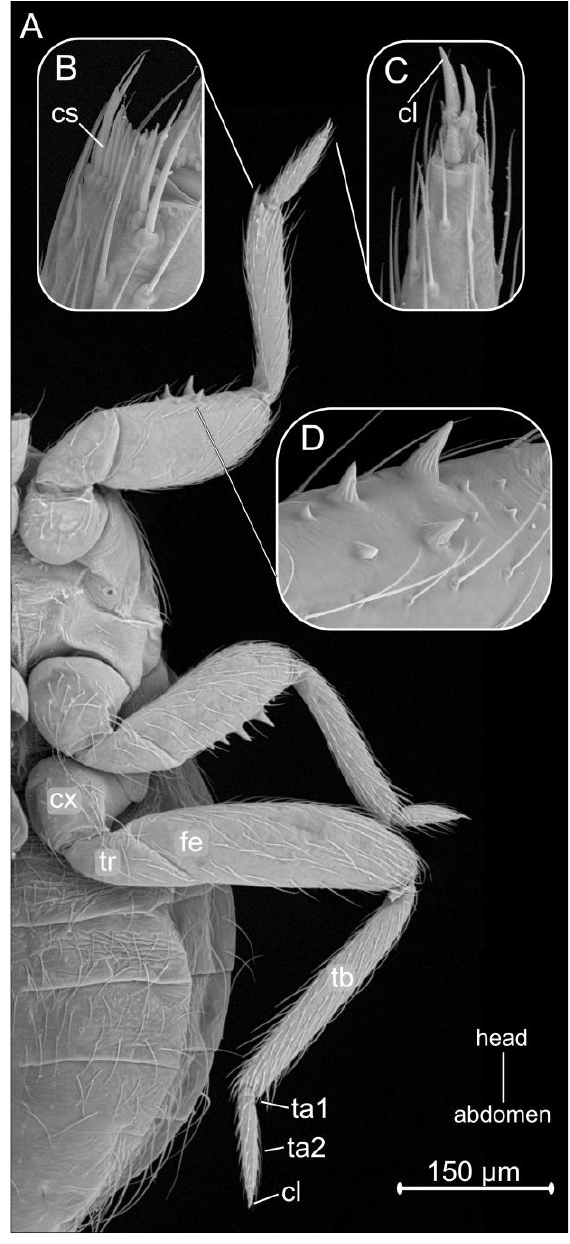
Figure 3. SEM micrograph of Embiophila myersi, nymph. ( A ) Thorax, legs and abdomen ventral view. ( B ) ‘Grooming’ setae, apical at the prothoracic tibia. ( C ) Prothoracic claws. ( D ) Rows of spines (raptorial) on the prothoracic femur. Abbreviation: cl — claw; cs — cleaning structure; cx — coxa; fe — femur; ta — tarsomere; tb — tibia; tr — trochanter.